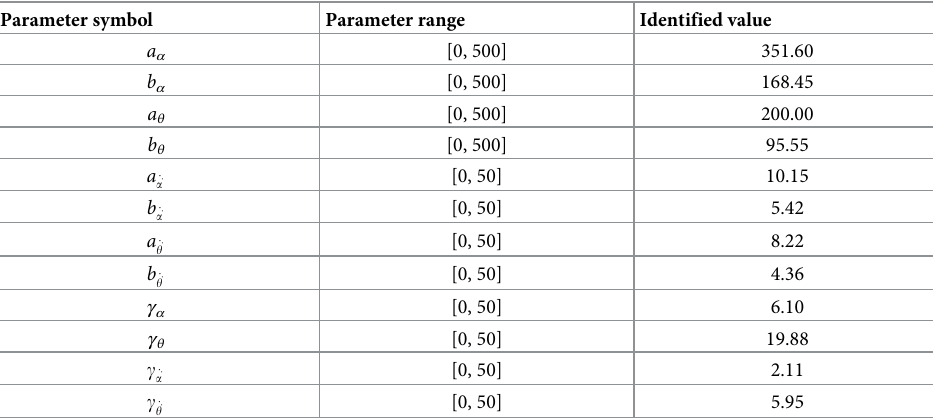
Table 5. Parameter selection of the error-phase-dependent